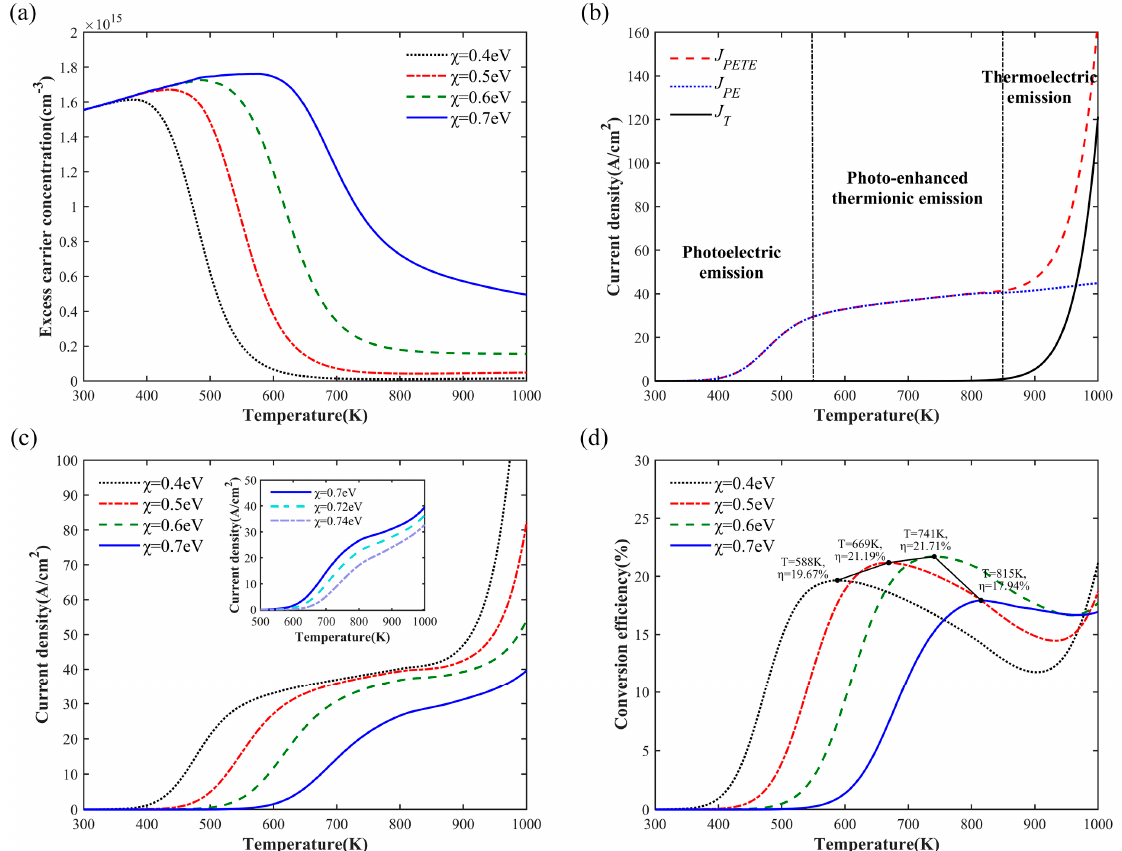
Figure 3. ( a ) The excess electron concentration n ( d ) versus temperature at different electron affinities. ( b ) At χ = 0.4 eV, the photon-enhanced current J PE , thermal current J T , and photon-enhanced thermal current J PETE versus temperature. At different electron affinities, ( c ) output current density versus temperature, ( d ) conversion efficiency versus temperature. The symbol “•” represents the maximum conversion efficiency.